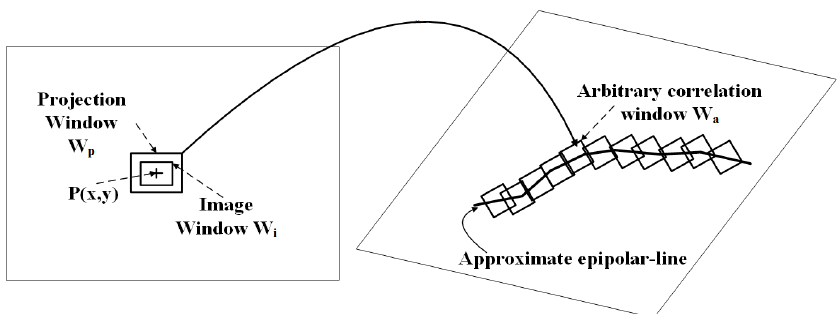
Figure 5. The principle of local geometric and radiometric distortion